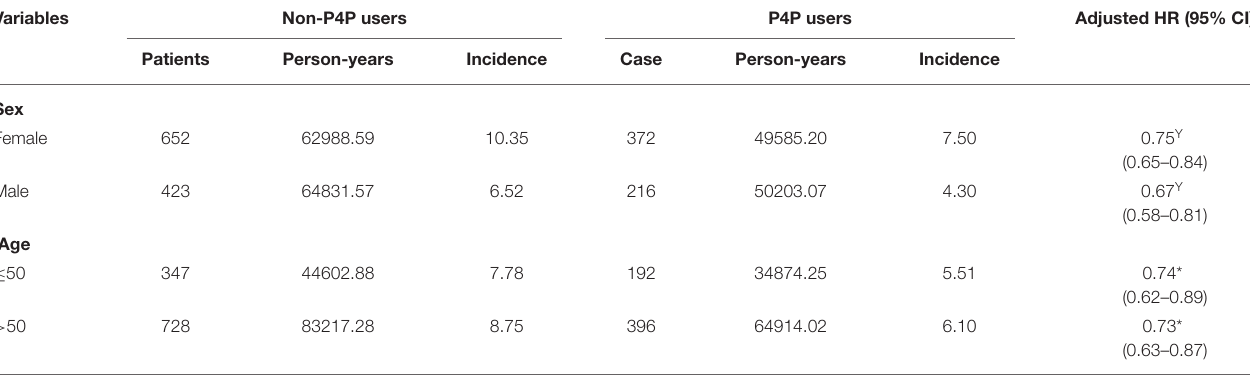
TABLE 3 | Incidence and depression risk for T2DM patients with and with no P4P use stratified by sex and